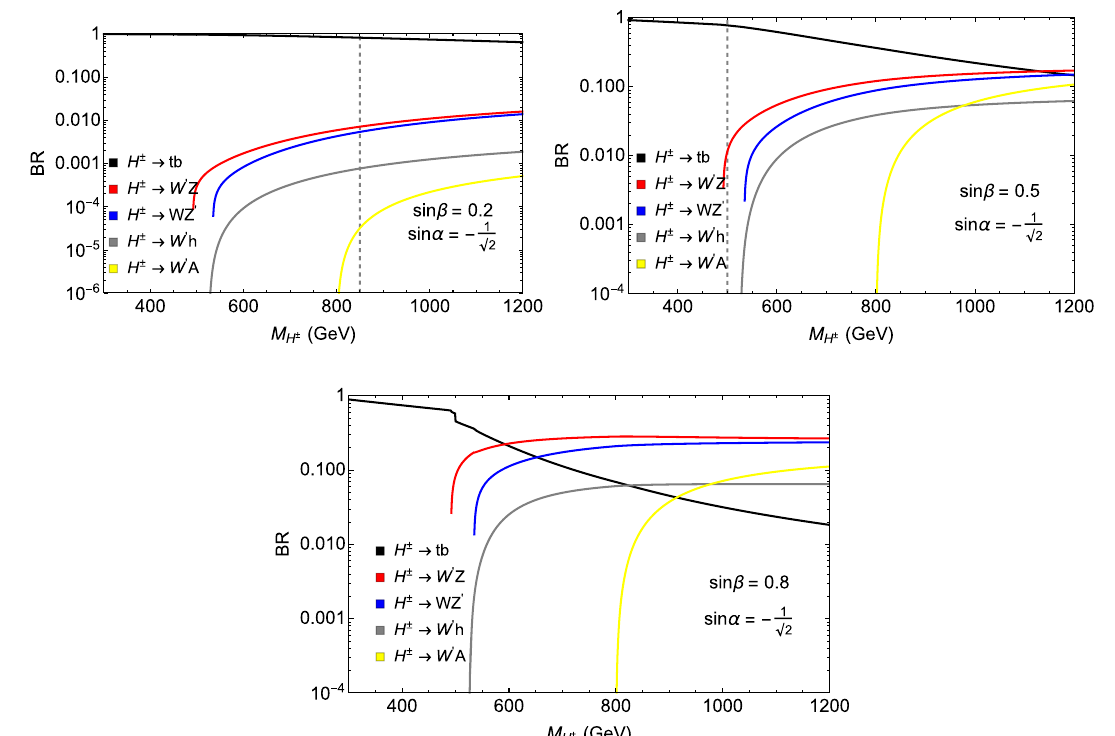
Fig. 16 In the above figure, we have presented the branching ratios of the charged Higgs into the different allowed channels for increasing values of sin β for a fixed sin α . In the top row, the regions to the left of the dashed vertical lines is excluded from the b → s γ constraint (see Fig.